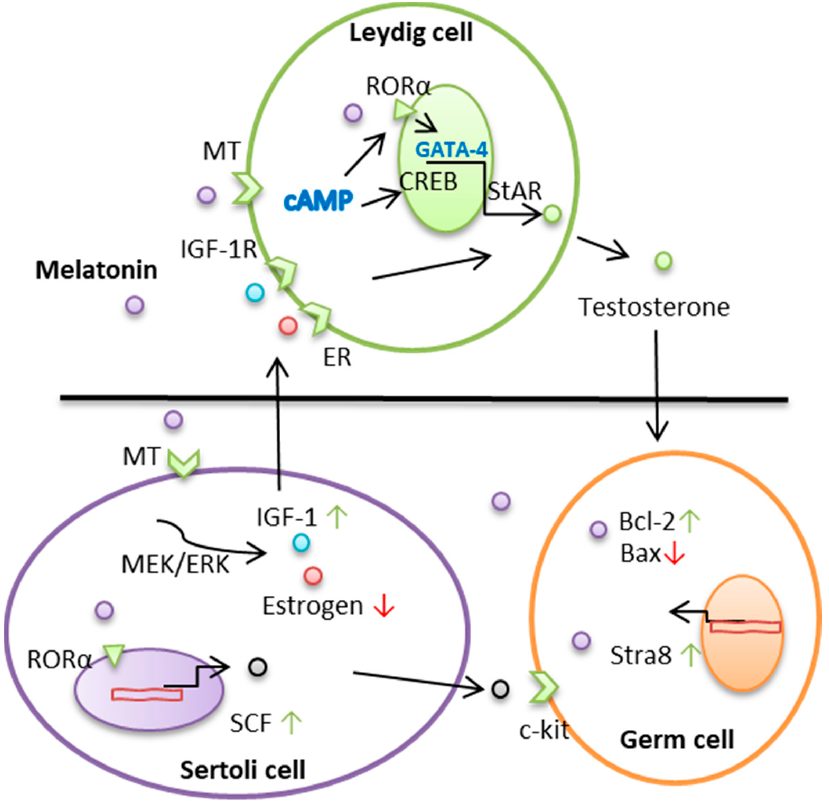
Figure 1. A schematic illustration of the melatonin regulates the synthesis of steroid hormones in rams.